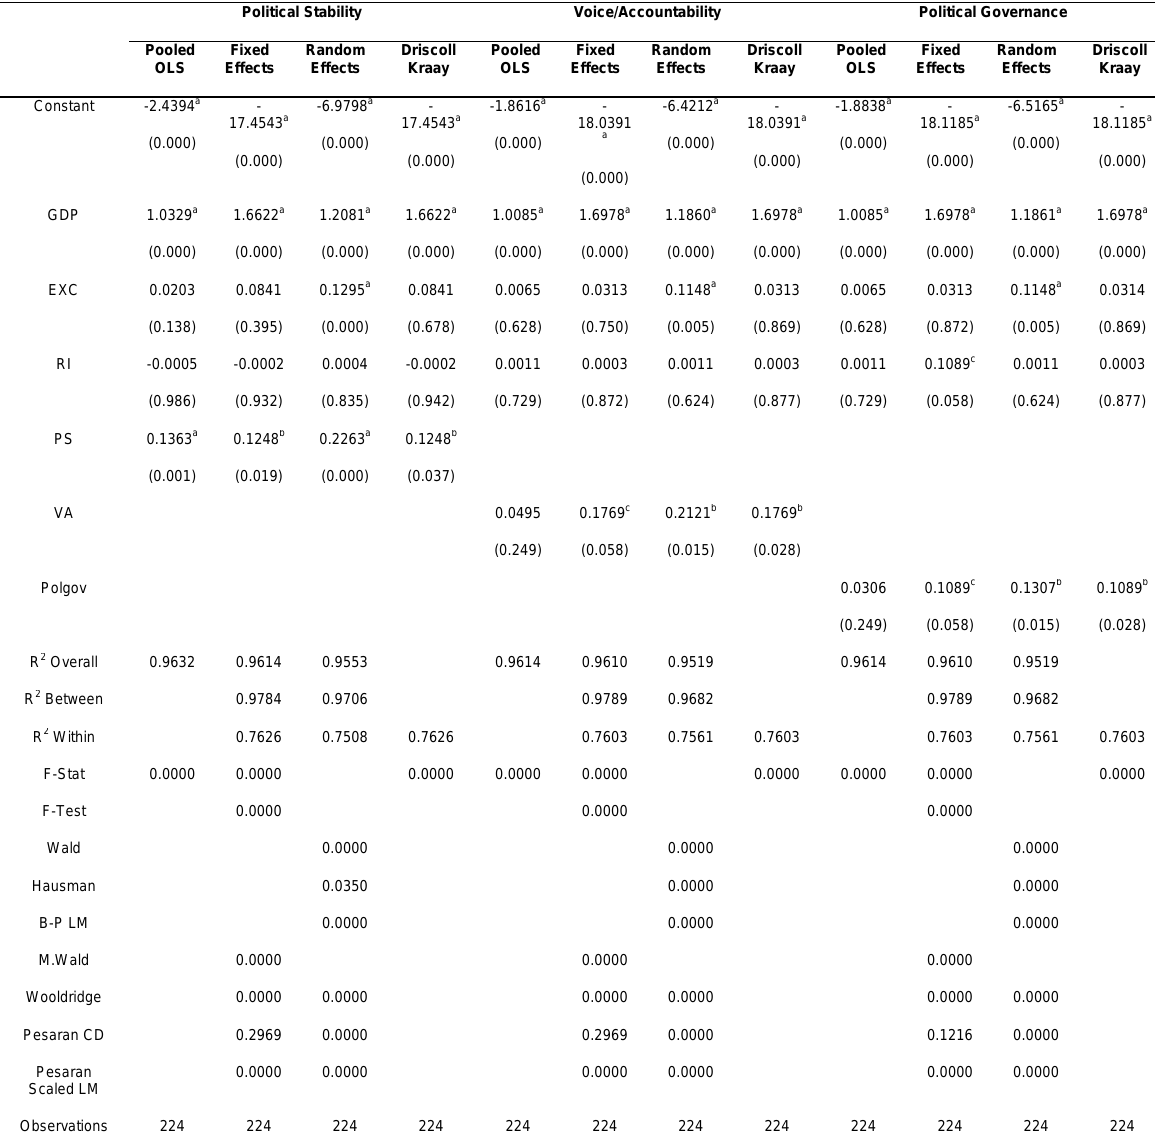
Table 3.4. Political Governance and Domestic Investment in Africa Political